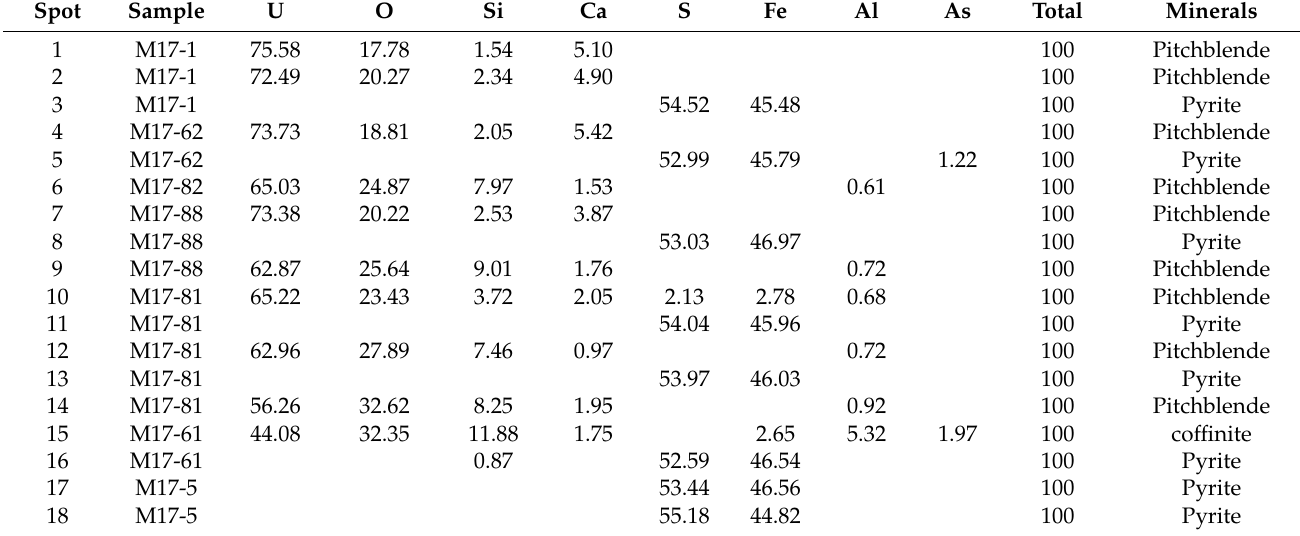
Table 2. SEM energy spectrum analytical results of mineral chemical compositions